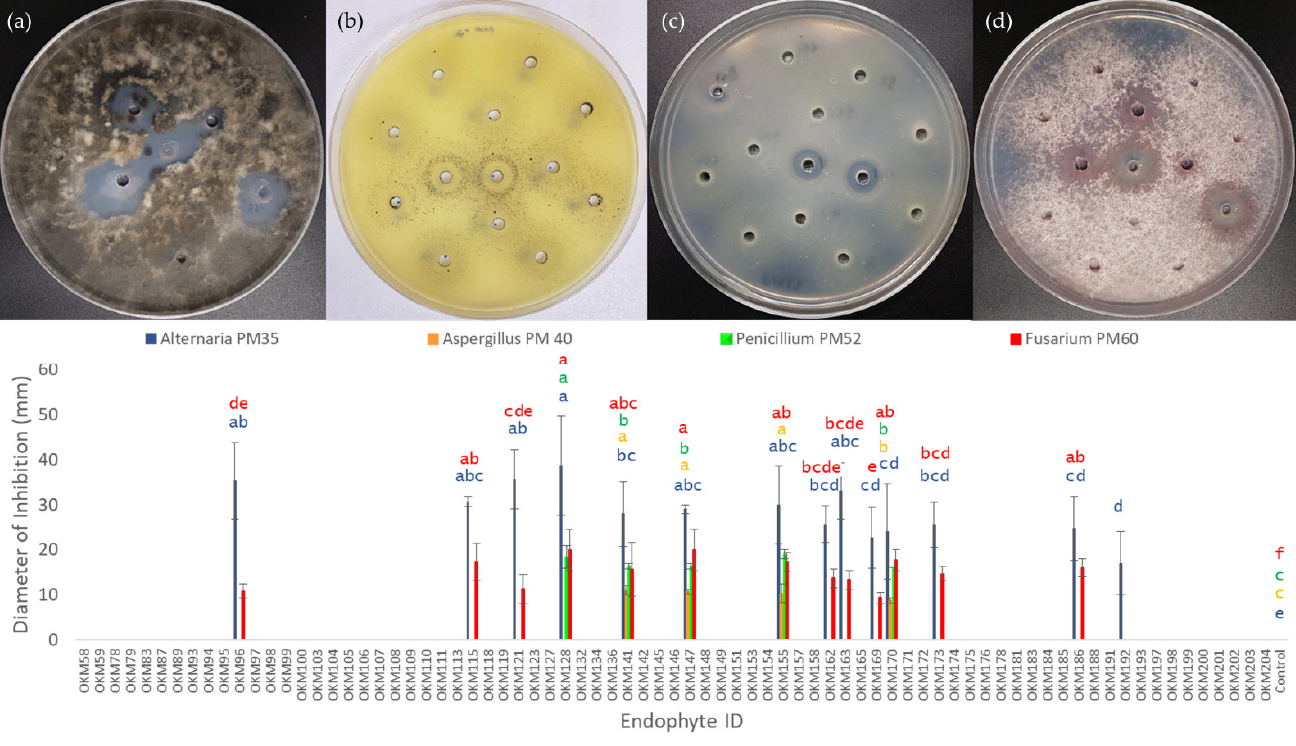
Figure 5. Biocontrol Activity of 78 Seed-Borne Cannabis Endophytes Against Seed-Borne Fungi. Four fungal isolates belonging to plant pathogenic genera were selected ( a ) Alternaria, ( b ) Aspergillus, ( c ) Penicillium, ( d ) Fusarium. Diameters of zones of inhibition were measured at 7 days post- inoculation with endophytes. Color-coded letters correspond to means within the same group as calculated by ANOVA and Tukey HSD test. Table 2. Summary of Anti-fungal Activity in Seed-borne Cannabis Endophytes.